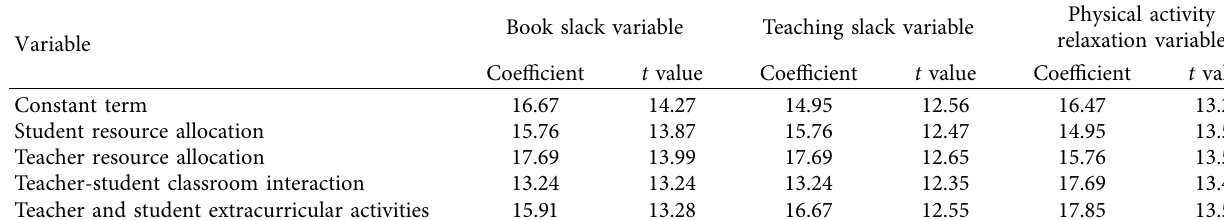
Table 6: Slack variables.